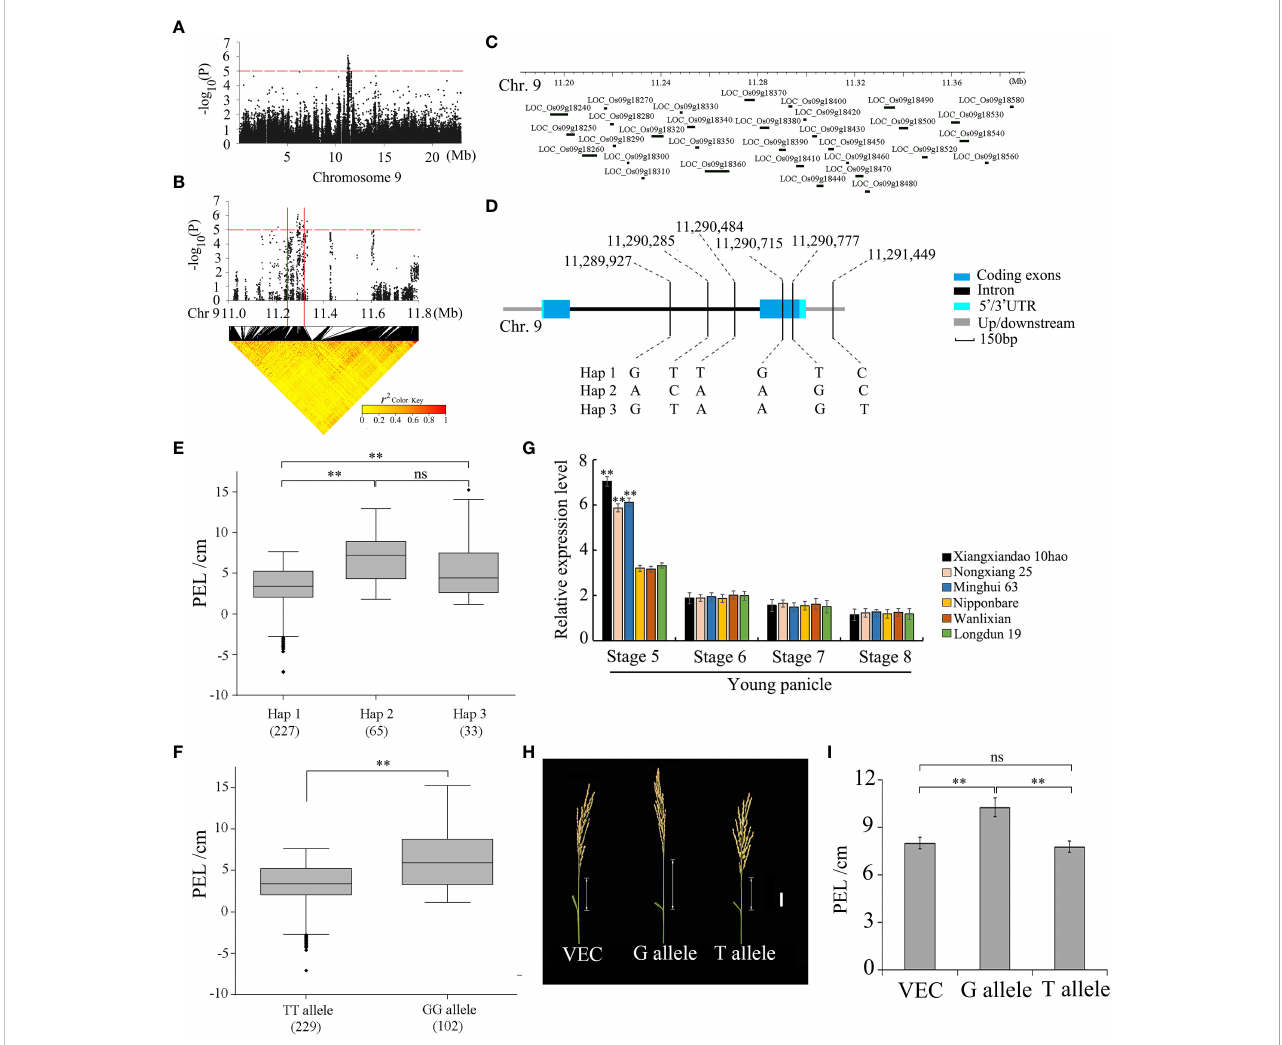
FIGURE 4 GWAS for PEL and identi fi cation of the causal gene PEL9 ( LOC_Os09g18390 ). (A) The Manhattan plot of chromosome 9 for PEL. In the Manhattan plots of chromosome 9, horizontal dashed lines indicate the signi fi cance threshold ( − log10P = 5.0). (B) Local Manhattan plot (top) and LD heatmap (bottom). The arrow indicates the position of the nucleotide variation in LOC_Os09g18390 . The candidate region lies between the solid red lines. (C) Identi fi cation of candidate genes in the region of qPEL9. (D) Haplotypes of LOC_Os09g18390 associated with PEL in rice. (E, F) Boxplots of PEL in accessions containing the different haplotypes (E) and elite alleles (F) . The box edges represent the upper and lower quantiles. The median value in black was shown in the middle of the box. Vertical lines represent the data from the lowest quantile to the top quantile. Asterisks indicate individuals falling outside the range of the whiskers. Differences between alleles were statistically analyzed using a Student ’ s t-test (** P < 0.01). (G) Relative expression of LOC_Os09g18390 in panicle below internode at development stages 5 – 8 of young panicle from the three accessions (Nipponbare, Nongxiang 25, and Longdun 19) with a long PEL and the three accessions (Xiangxiandao 10hao, Wanlixian, and Minghui 63) with a short PEL, determined by qRT-PCR (** P < 0.01, Student ’ s t-test). Data are presented as means ± s.e.; n = 3 independent biological replicates. (H) Images of panicles of transgenic plants transformed with the empty vector (VEC), the G allele, and the T allele. Scale bar, 3 cm. (I) PEL of transgenic plants. Data are presented as means ± s.e. (n = 20). PEL, panicle elongation